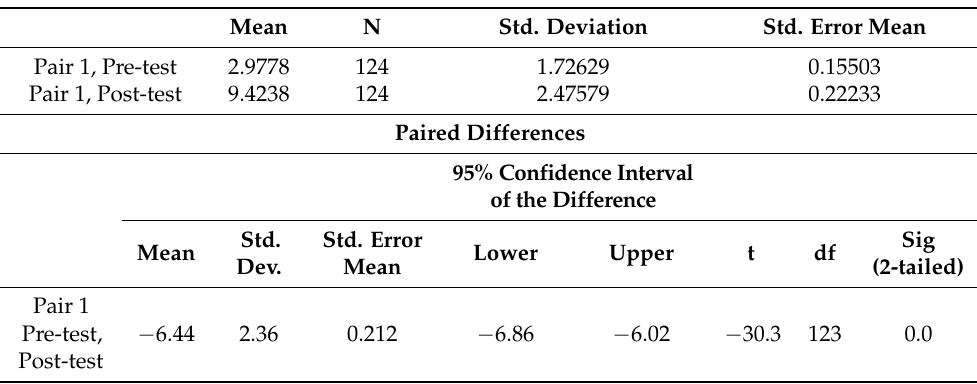
Table 5. Paired samples statistics: outcomes of the Student’s t -test for all students.